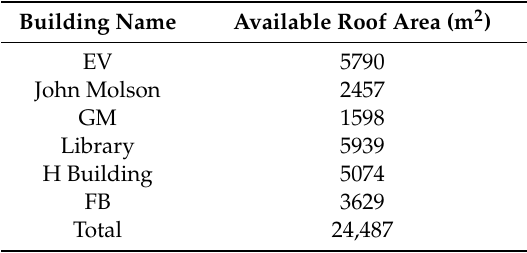
Table 3. Available roof area for installing components .